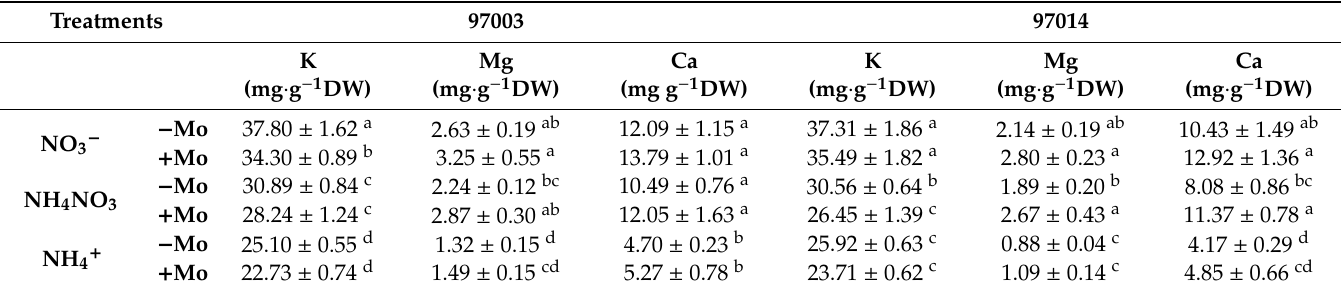
Table 2. Influence of Molybdenum (Mo) supply on potassium, magnesium, and calcium concentrations in leaves of Mo-e ffi cient ‘97003’ and Mo-ine ffi cient ‘97014’ winter wheat cultivars under di ff erent N sources.